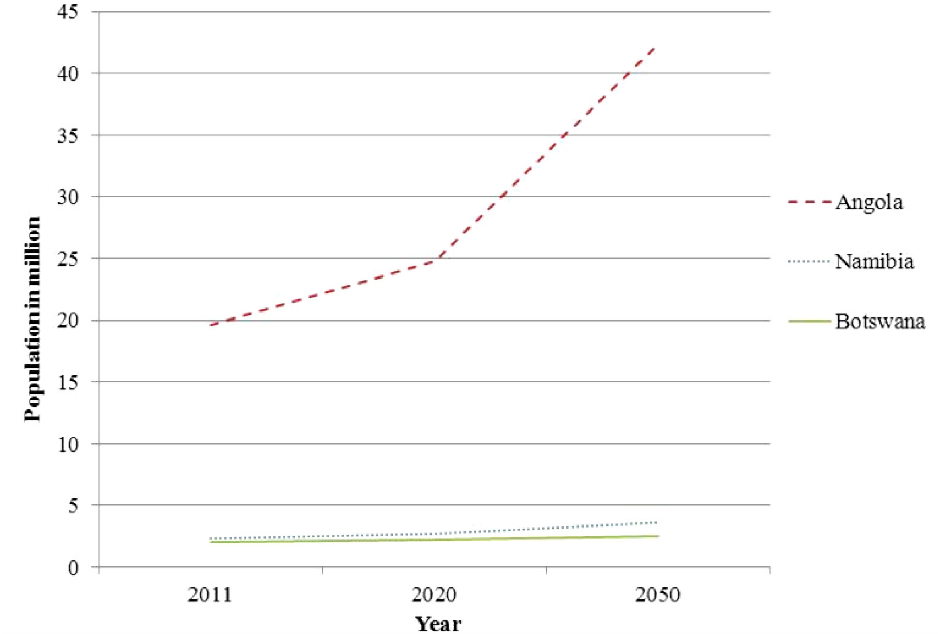
Figure 3. Population in 2011 and projection for 2020 and 2050 in Angola, Botswana and Namibia (own representation based on data from [24–27]).